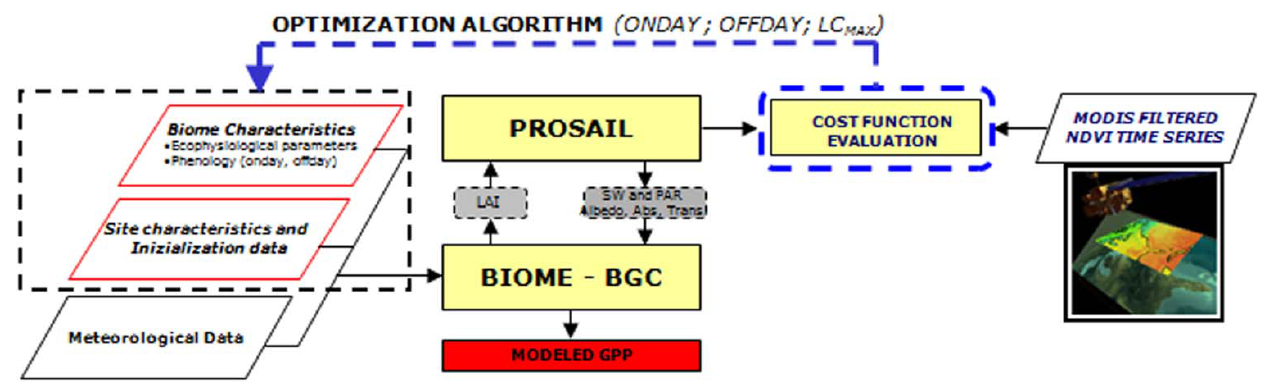
Figure 3. Flow chart of second-step optimization. Yellow blocks represent the models, parallelepipeds represent the model input parameters and the data for model optimization, grey boxes represent the state variables passed between coupled models while the red box is the model